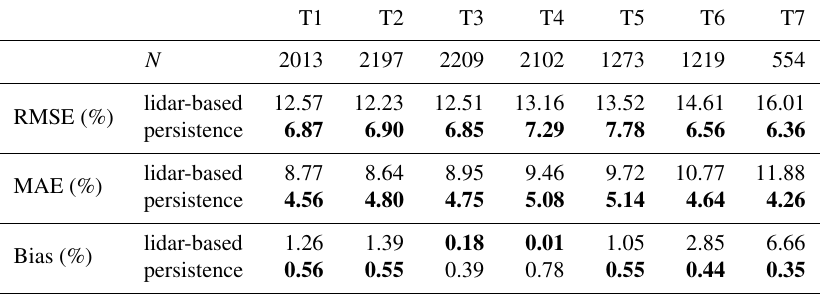
Table 2. Number of valid scans N , RMSE, MAE and bias for turbines T1–T7 for the lidar-based forecast and persistence during stable and neutral stratification. Scores are given in percent of the turbines’ nominal power with the lowest values in bold. T1